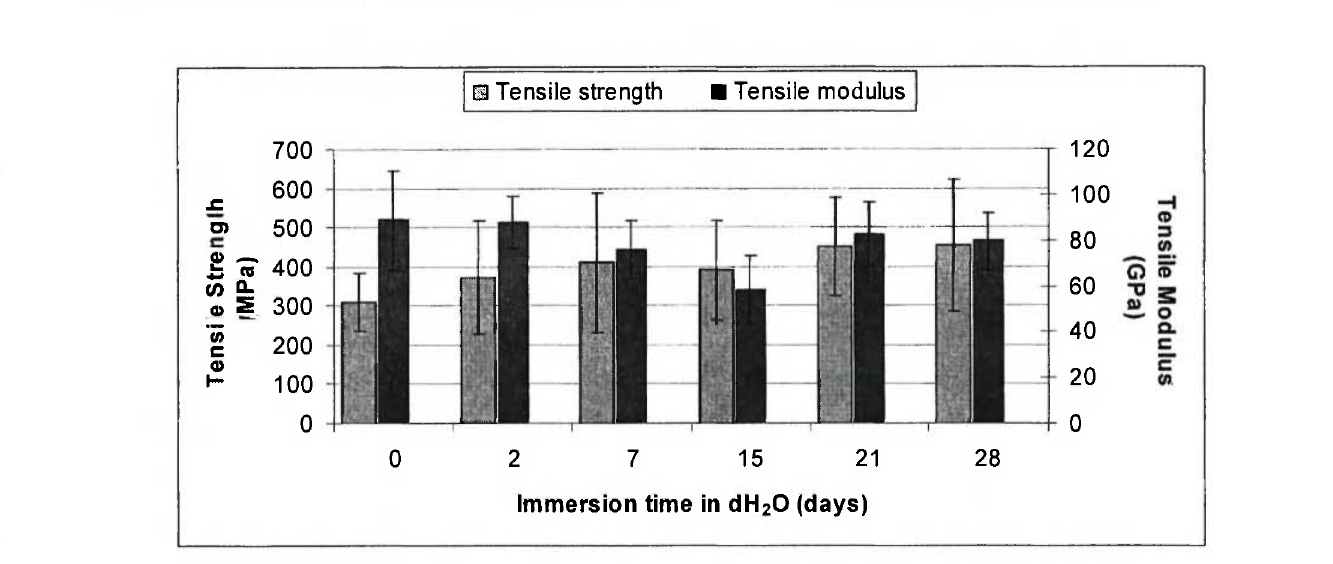
Fig. 3: Comparison of tensile strength and modulus of P40 glass fibres as a function of immersion time in deionised water (dH 2 0) at 37 °C. Mean and standard deviation values presented are based on 25 repeat specimens.